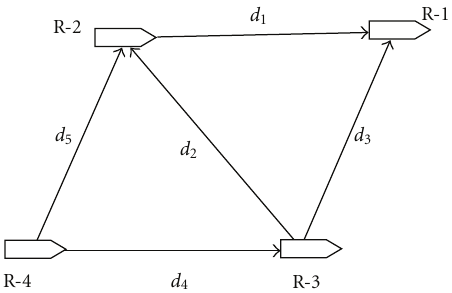
Figure 2: Quadrilateral formation of leader-follower structure. In this figure, the notations are as follows. R-1 denotes the leader and R-2 denotes the first follower, R-3 is for the ordinary follower-1 and R-4 is for ordinary